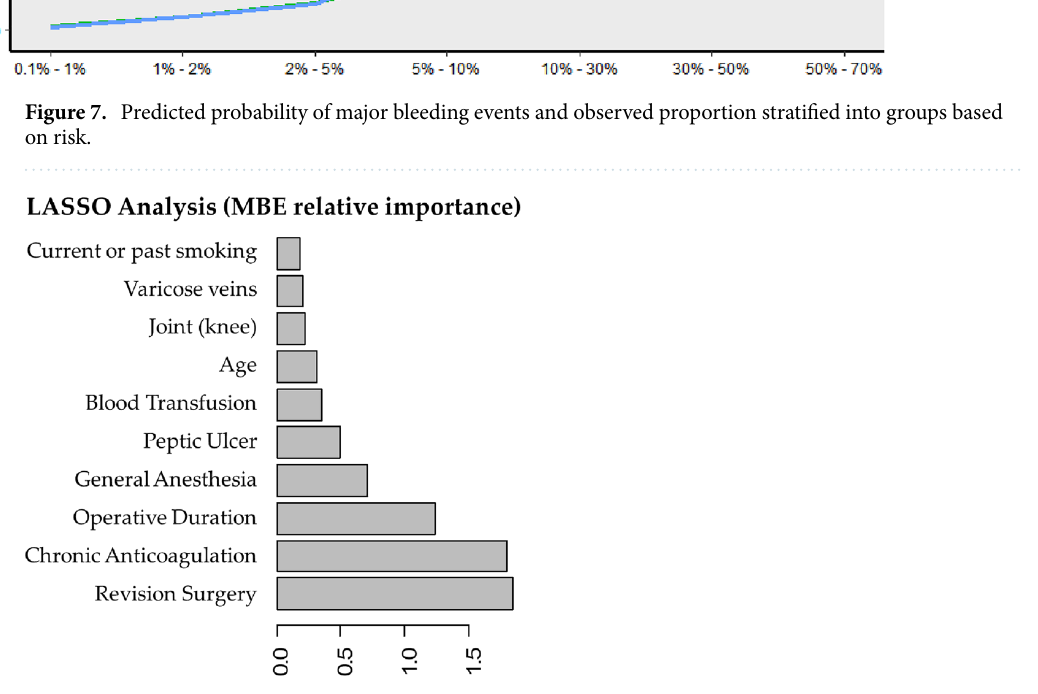
Figure 8. Top ten important predictors for major bleeding event (MBE) as captured by Lasso